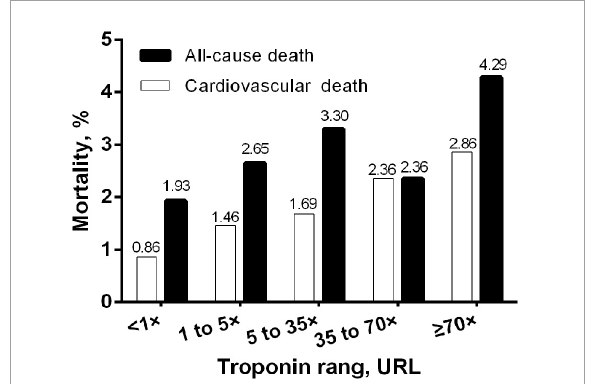
FIGURE2 Bar graph of 3-year mortality rate by different ranges of post-PCI peak cTnI normalized to the upper reference limit. URL, upper reference limit; cTnI, cardiac troponin